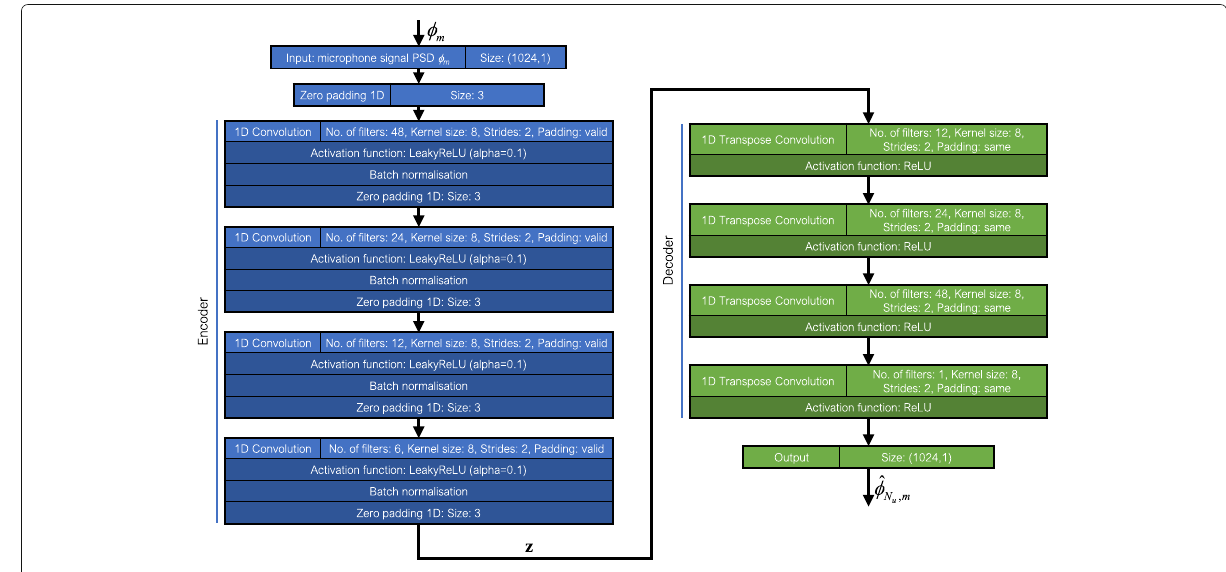
Fig. 3 DAE architecture of the SNR response scaling algorithm